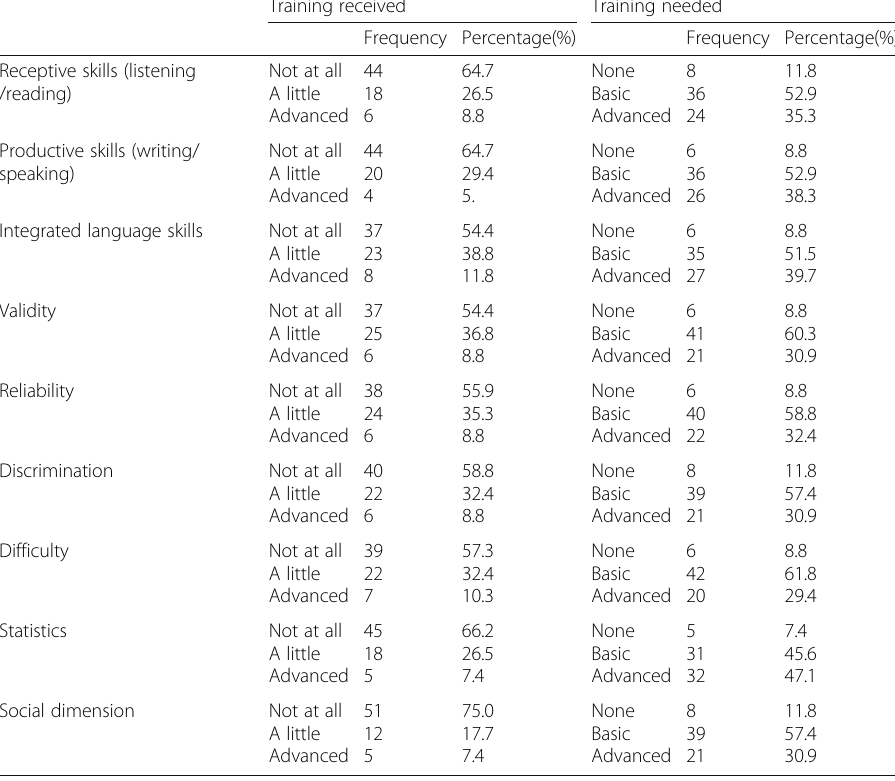
Table 2 Respondents ’ assessment training received and needed in content and